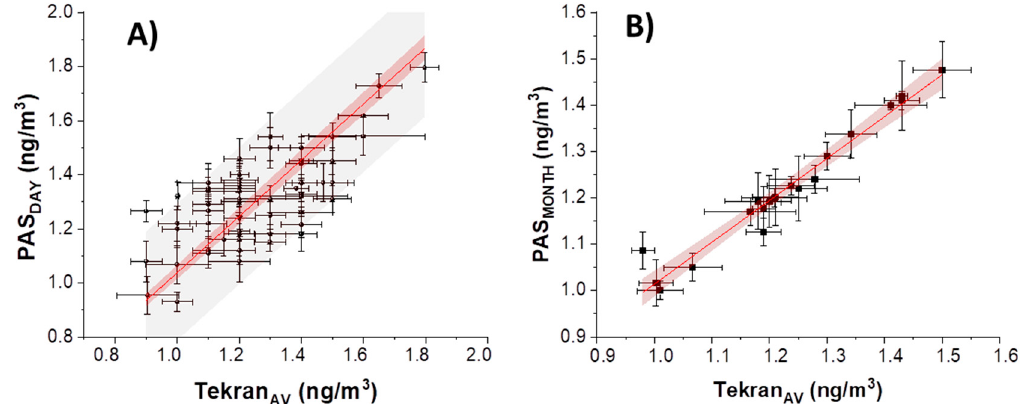
Figure 7. ( A ) Linear fitting of PAS data vs. Tekran collected day by day forced to pass through 0; ( B ) linear fitting of PAS data vs. Tekran collected monthly (SR: 0.014 m 3 / day) forced to pass through 0. The red band depicts a 95% confidence band; the gray band depicts 90% of prediction.